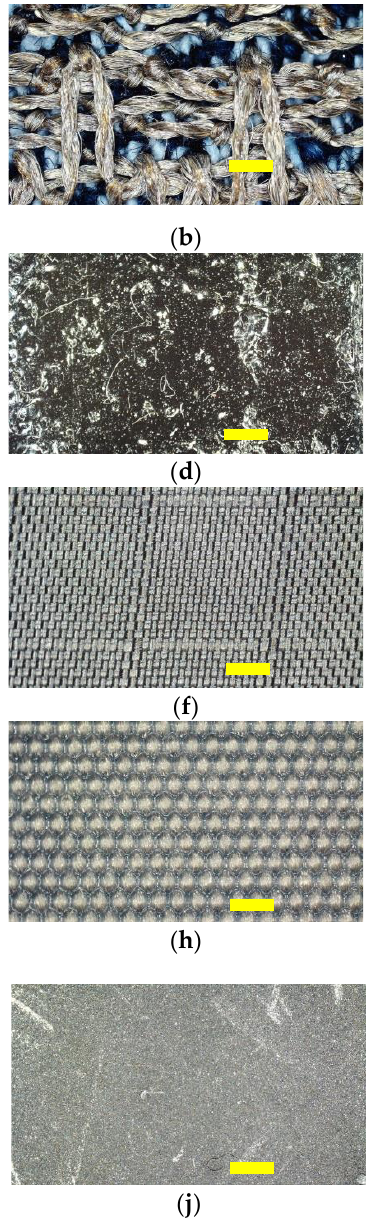
Figure 2. Textile electrodes used in this study: ( a ) electrode 8; ( b ) electrode 4.3; ( c ) electrode 4.2; ( d ) Powersil on cotton; ( e ) Ripstop Silver; ( f ) Shieldit Super; ( g ) sewn Shieldex; ( h ) PEDOT:PSS coating; ( i ) Tubicoat coating; ( j ) non-textile graphite foil. Yellow scale bars depict 1 mm. The moss-embroidered electrode 8 and the stitched electrodes 4.3 and 4.2 were re-used since they were found to be best suited for bioimpedance measurements [46], suggesting that they may also be suitable for ECG measurements.